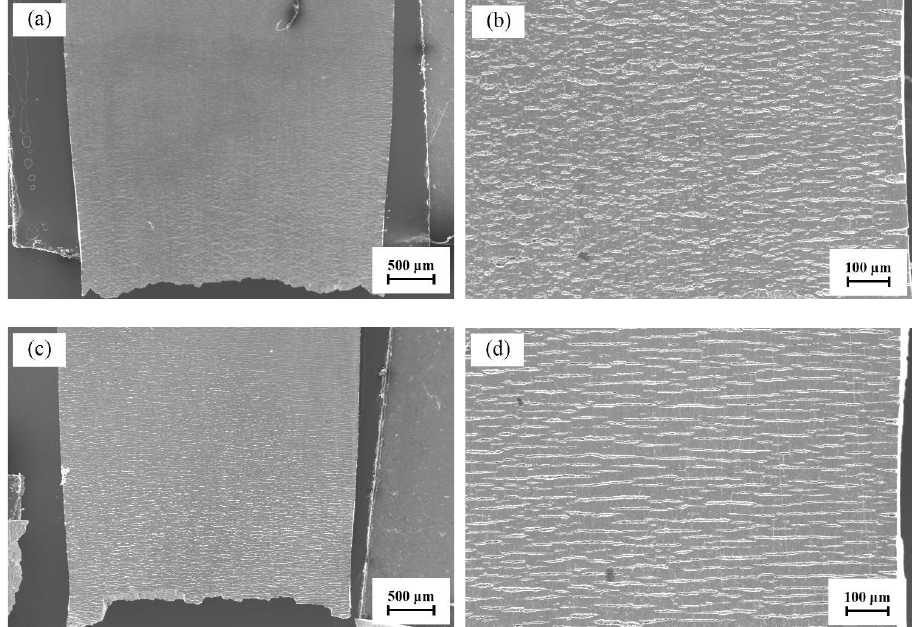
Figure 10. Fracture edge morphologies of Ti6Al4V alloy under different hydrostatic pressures: ( a , b ) 0.1 MPa; ( c , d ) 50 MPa. ( a , b ) 0.1 MPa; ( c , d ) 50 MPa.